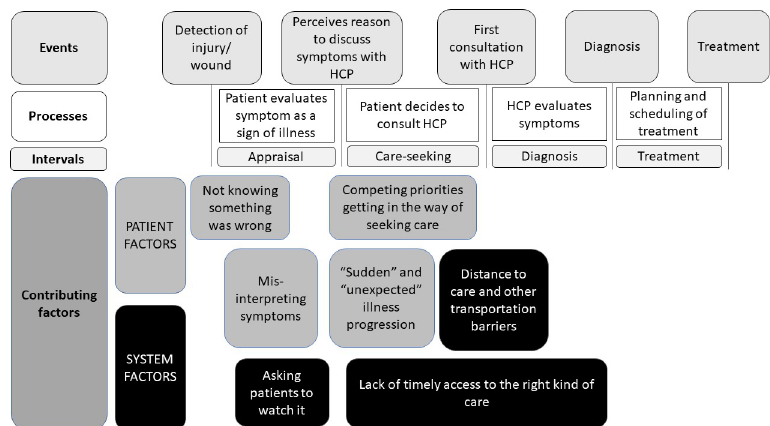
Fig 1. Depiction of the stages of delay and how themes identified fit into those stages. This figure was adapted from Walter et al. [15] and conceptualizes delay intervals occurring between phases of decision-making. The appraisal interval describes the time from becoming aware of bodily change to perceiving a reason to discuss symptoms with a healthcare provider (HCP). During this appraisal interval, patients may self-manage their foot. The care-seeking interval is the time between perceiving a reason to discuss symptoms with a HCP and meeting with a HCP. The diagnosis interval is the time between meeting with a HCP and having a provider diagnose the foot as having an ulcer/ gangrene/etc. The treatment interval is the time between when a diagnosis is made until treatment is initiated. Two of the patient factors identified occurred during the appraisal interval, while two others occurred during the care-seeking interval. “Asking patients to watch it”, a system-level factors impacted the appraisal interval because responsibility of evaluating worsening of symptoms was returned to the patient. Lack of timely access to care delayed care-seeking and diagnosis. Distance to care and other transportation barriers delayed